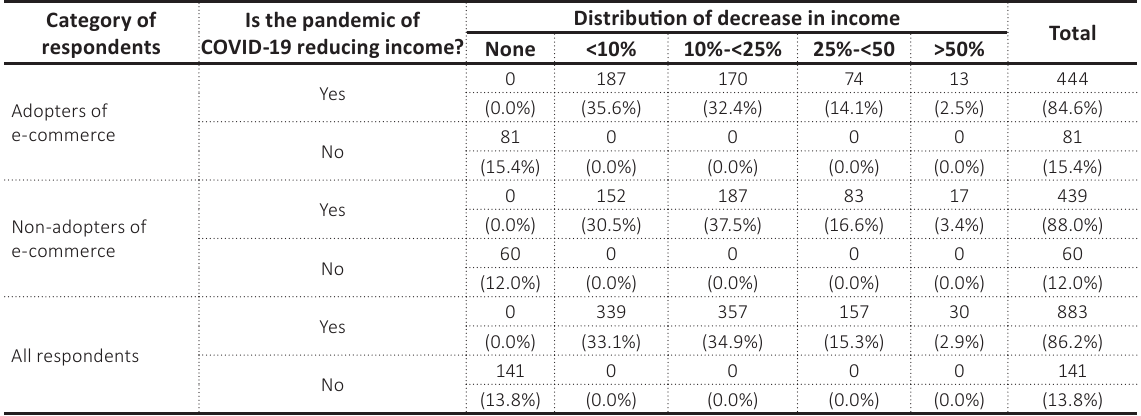
Table 2. Distribution of decrease in income of small enterprises